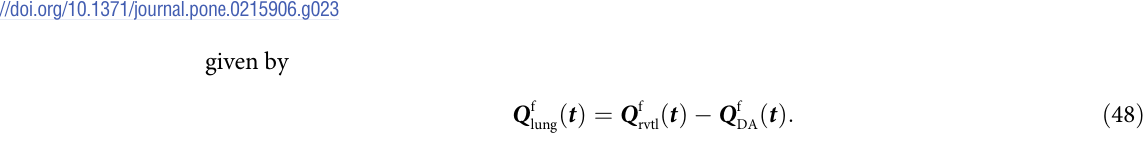
Fig 23. Fetal blood flow through the left ventricle vs. gestational age. The logistic model (solid line) given by Eq 45 was selected as the most parsimonious model in our analysis. The model of Kiserud et al. [38] was calibrated using the same data set [38] used by us.